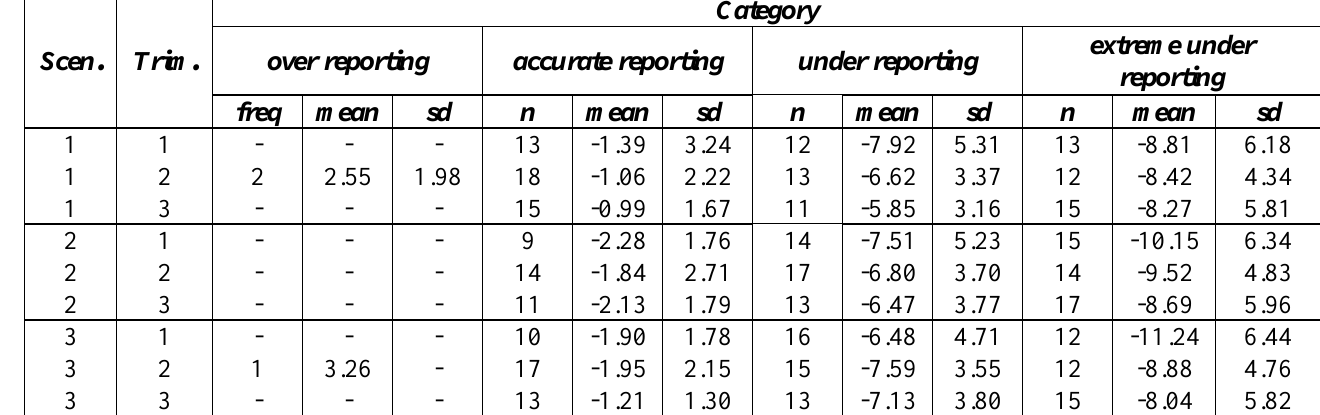
Table 1. Classification of women based on the individual MC corrections. For each category, the first column (“n”) is the number of women in that classification group. The second column (“mean”) is the mean of the differences between the weighted self-report and the number of cigarettes from cotinine. The third column (“sd”) is the standard deviation of these differences.